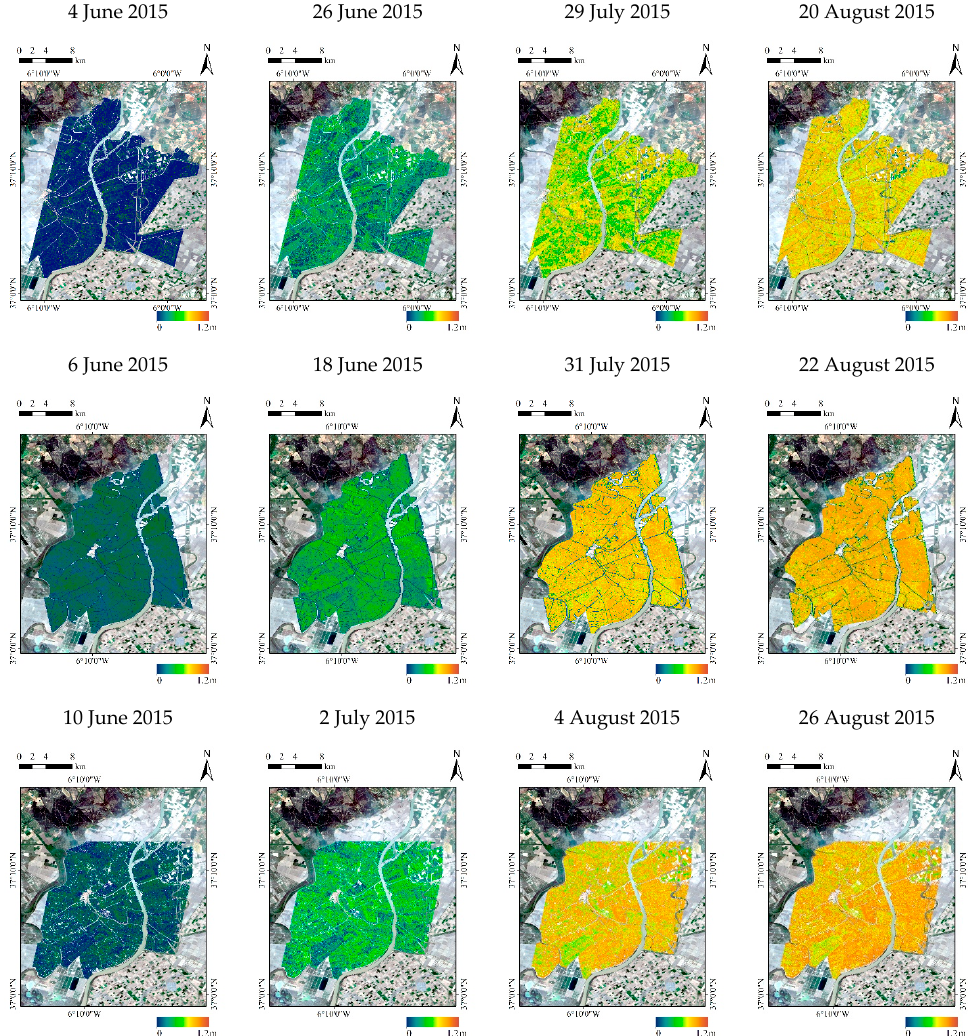
Figure 13. Maps of rice height for four dates along the growth cycle obtained by the proposed method with 22°, 30°, and 39° incidence angles (displayed in order from top to bottom).